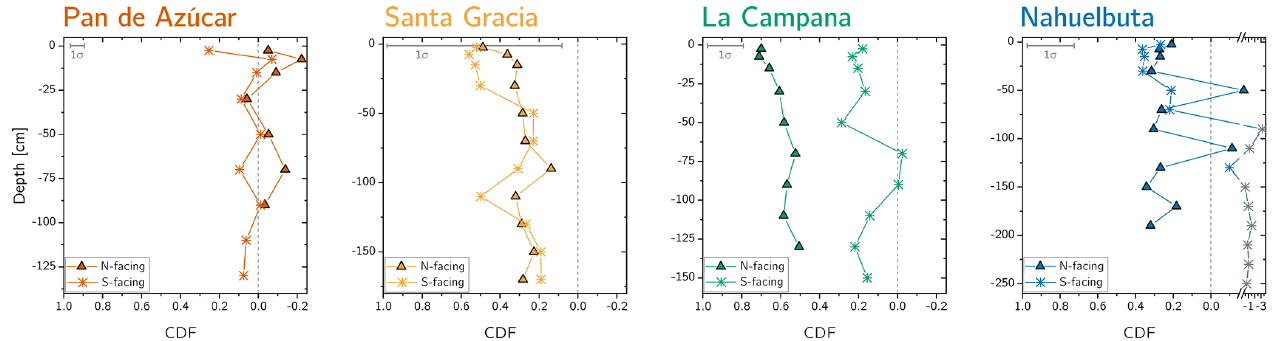
Figure 3. Chemical depletion fraction (CDF) for each study sites’ north- and south-facing profile. The accuracy of the absolute CDF values is limited by the variability in the bedrock’s Zr concentration in the respective study sites and are indicated as a grey 1 σ bar (Data Table S1). The grey symbols correspond mainly to saprolite samples in the south-facing regolith profile in Nahuelbuta and are excluded from further consideration. Note that in Nahuelbuta a different scaling compared to the other study sites applies after the axis